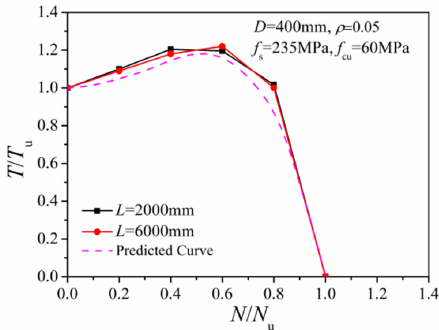
Figure 13. Effect of different slenderness ratios.